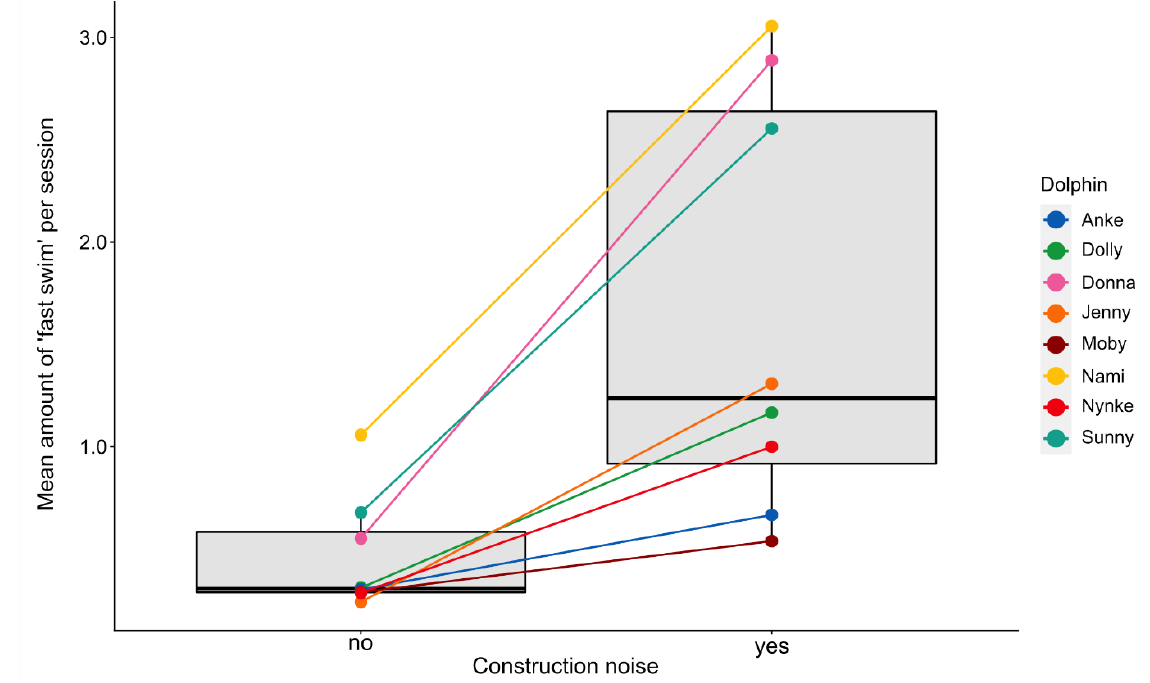
Figure 5. Mean frequencies of fast swimming observed during periods with and without construction noise. All periods with and all periods without construction noise were pooled to deduce a mean value for each individual.